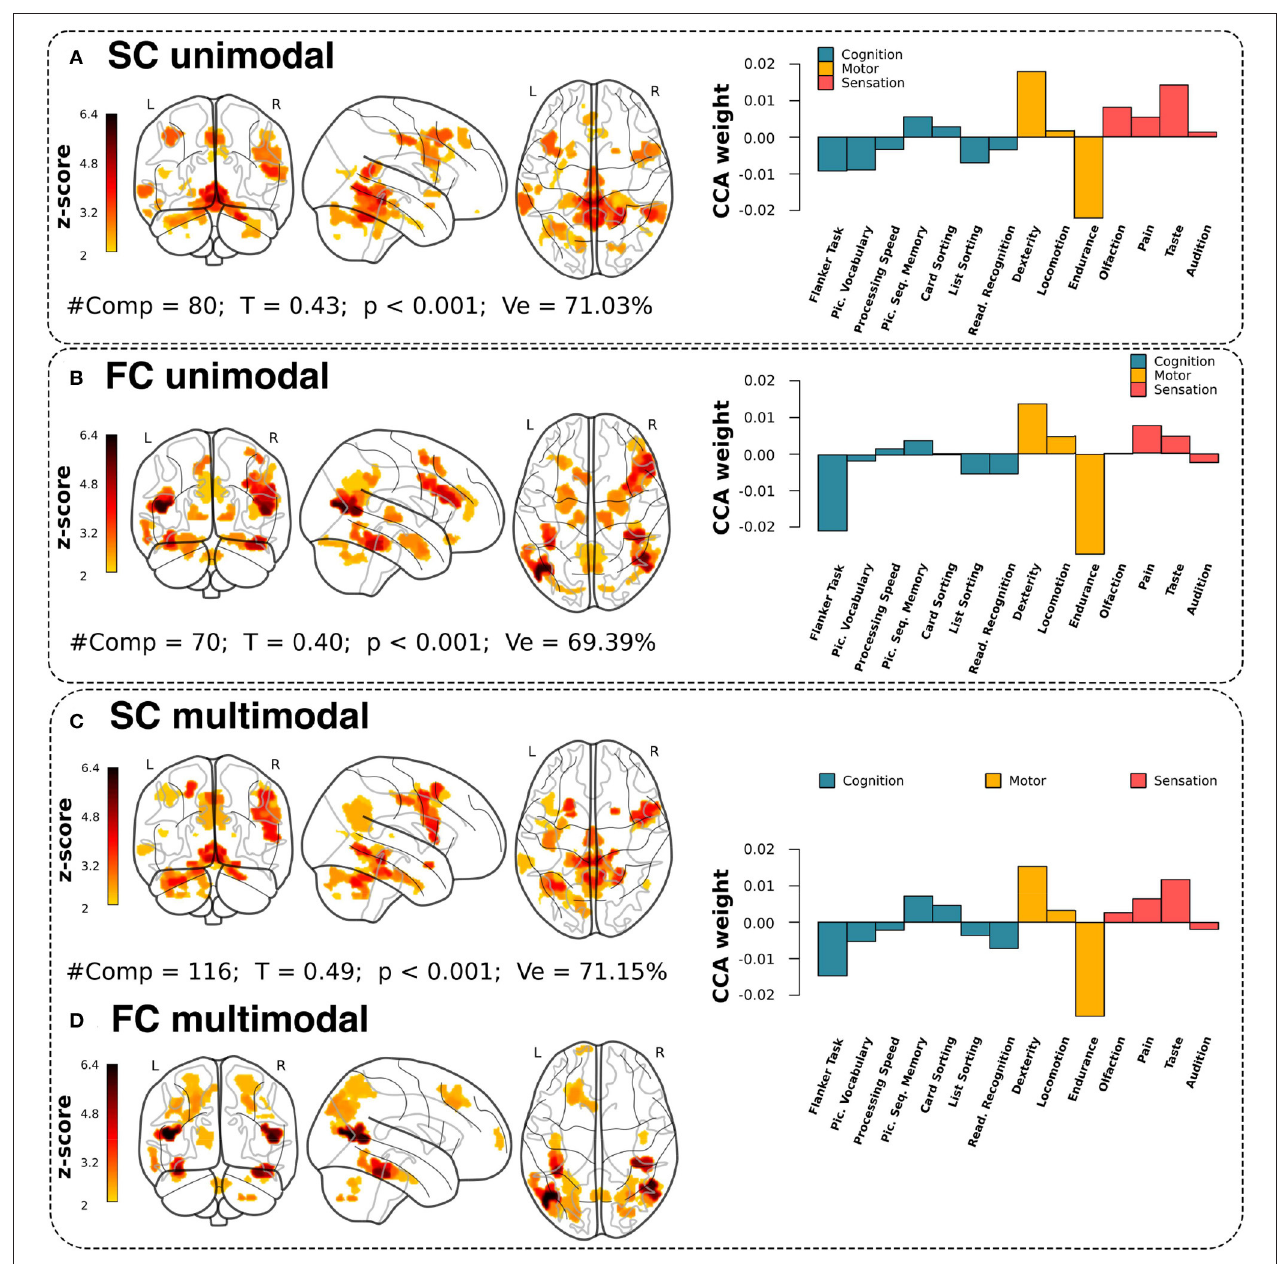
FIGURE 2 | Brain maps and CCA weights for unimodal and multimodal associations. Final maps built from the multidomain CCA solution with the highest correlation coefficient (T) correlation between the X variables (the PCA components from each modality) and the Y variables (neuro-behavioral metrics from multiple domains). From top to bottom, (A) SC unimodal, (B) FC unimodal, and (C,D) SC+FC multimodal, plotting separately the SC and FC contributions. (A–D) Number of PCs used in the model (#PC), maximum correlation in the association achieved by the first canonical mode (T), p-value statistical significance (p), and the amount of variance explained after PCA (Ve). For visualization, all maps were threshold to values such Z > 2. The right panels provide the CCA weights for each neuro-behavioral domain at the maximum association between connectivity and behavior.